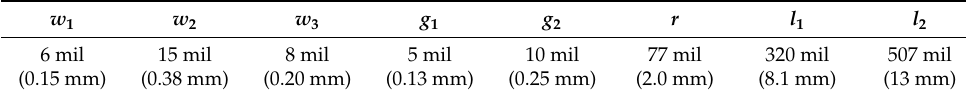
Table 1. Design parameters of the proposed compact CPS-to-MSL transition.